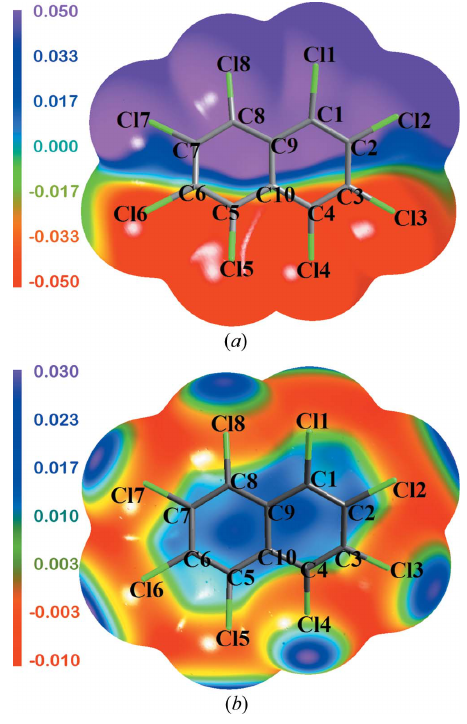
Figure 7 ESP map drawn at the isoelectron density surface at 0.001 a.u. for ( a ) crystalline geometry and ( b ) for solvated optimized geometry.